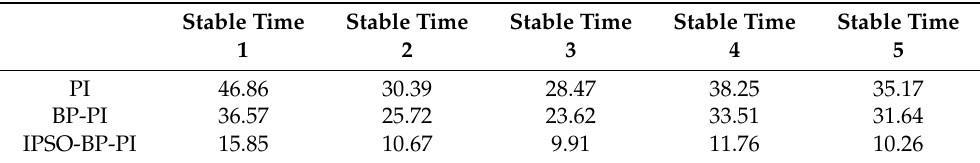
Figure 11. Frequency regulation curves with random perturbation using three techniques. Table 4. Stable time of the